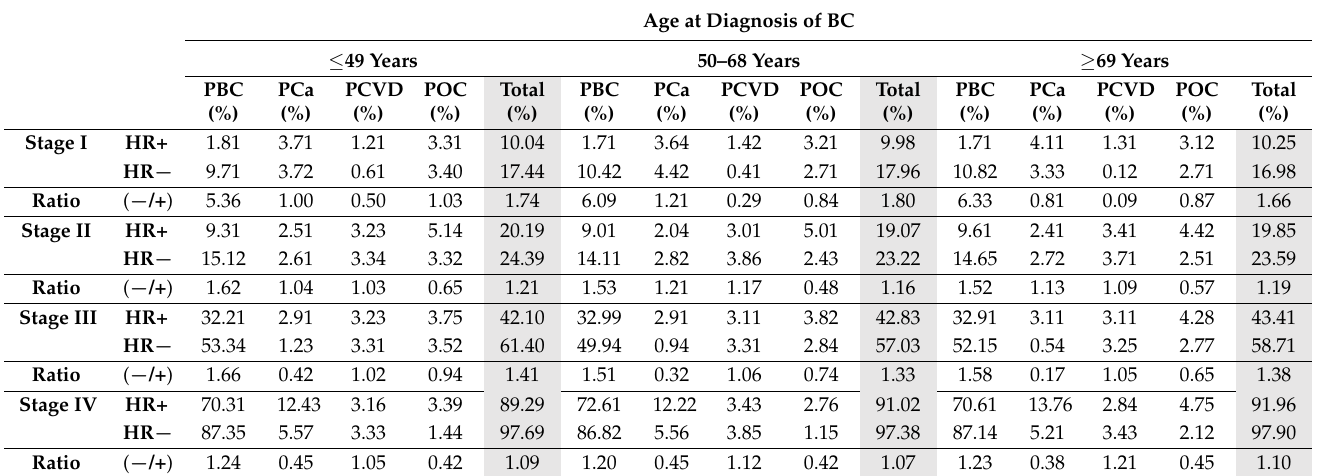
Table 4. 10-year cause-specific probabilities of death according to age, stage, and hormone receptor status in the cohort of patients diagnosed in